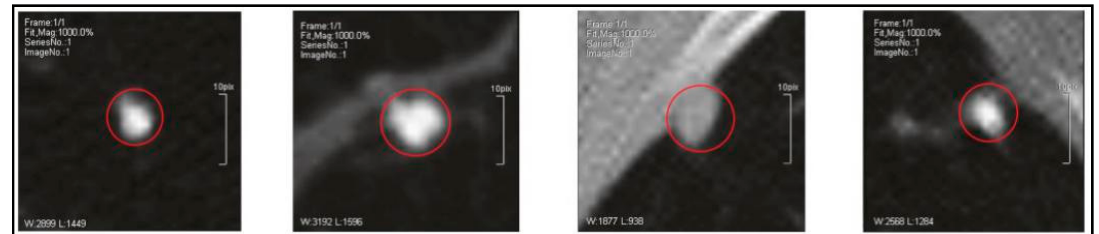
Figure 4. Demonstration of four types of lung nodule CT image, shown from left to right, W, V, J, and P, respectively [12]. Red circles denote the locations of the nodule.